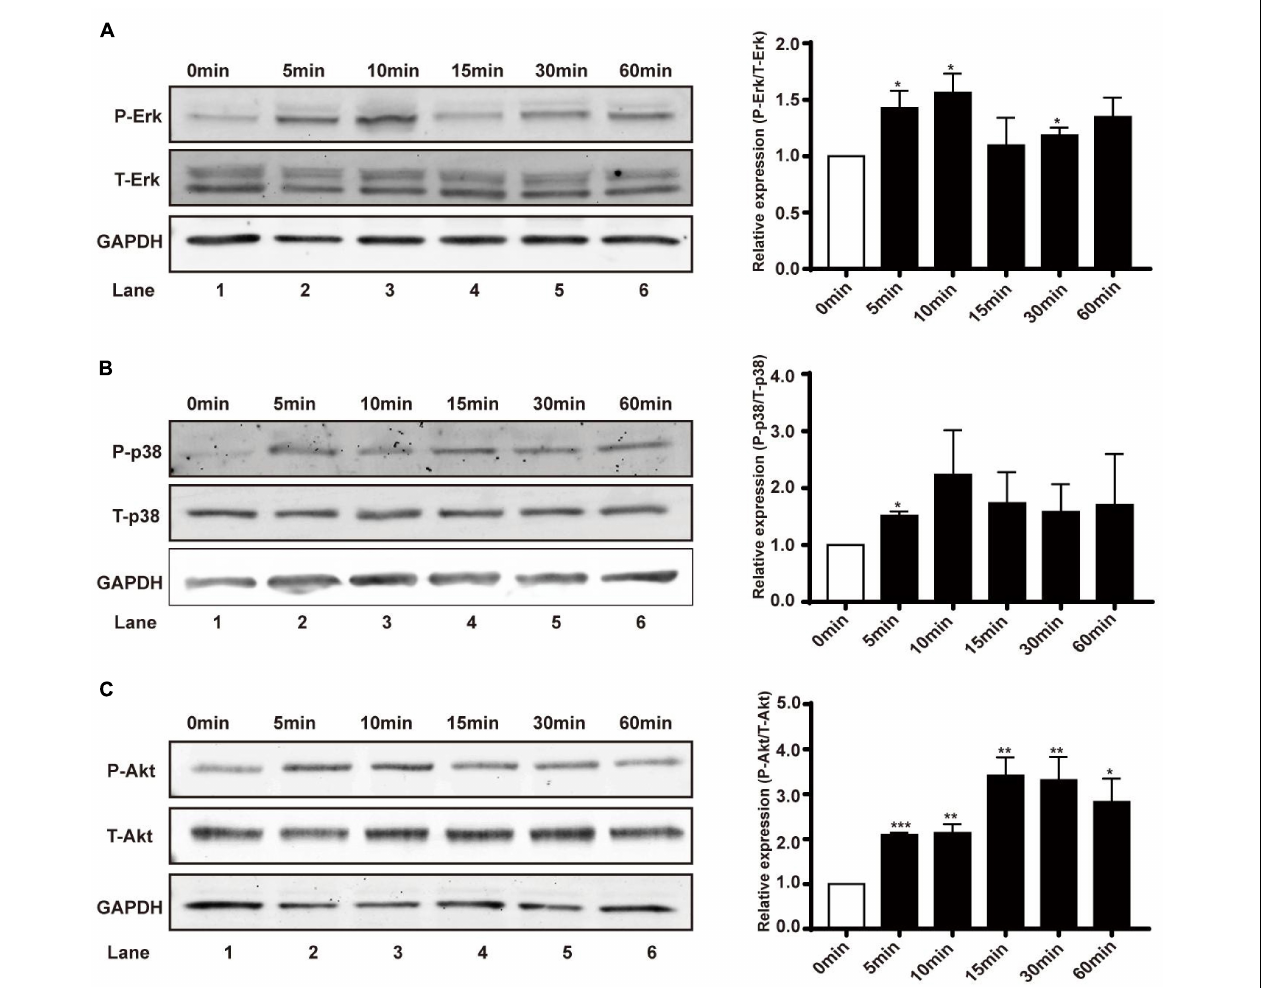
FIGURE 4 | Effect of EF on activation of Erk1/2, p38 MAPK, and Akt signaling pathways in human renal tubular epithelial cells. (A–C) Protein expression of Erk1/2 and Erk1/2-phosphorylation, p38 and p38-phosphorylation, and Akt and Akt-phosphorylation in different treatment groups (before or after EF stimulation) were detected by western blotting with anti-Erk1/2 and anti-p-Erk1/2, and anti-p38 and anti-p-p38, and anti-Akt and anti-p-Akt. GAPDH was used as an internal control. Data are presented as the mean ± SEM of at least three biological replicates, *p < 0.05, **P < 0.01, or ***P < 0.001, compared with control before EF treatment (0